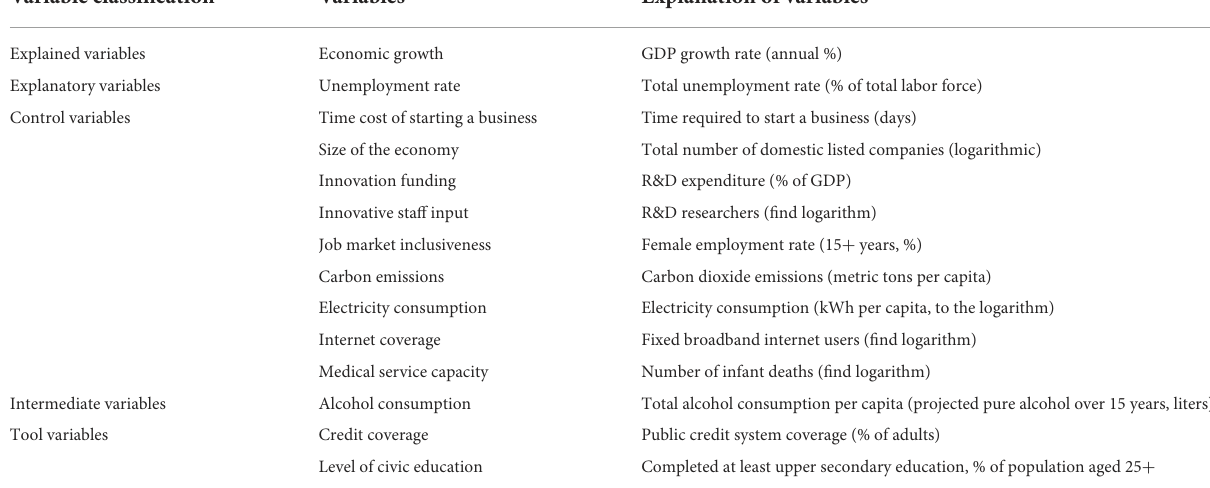
TABLE 1 Description of